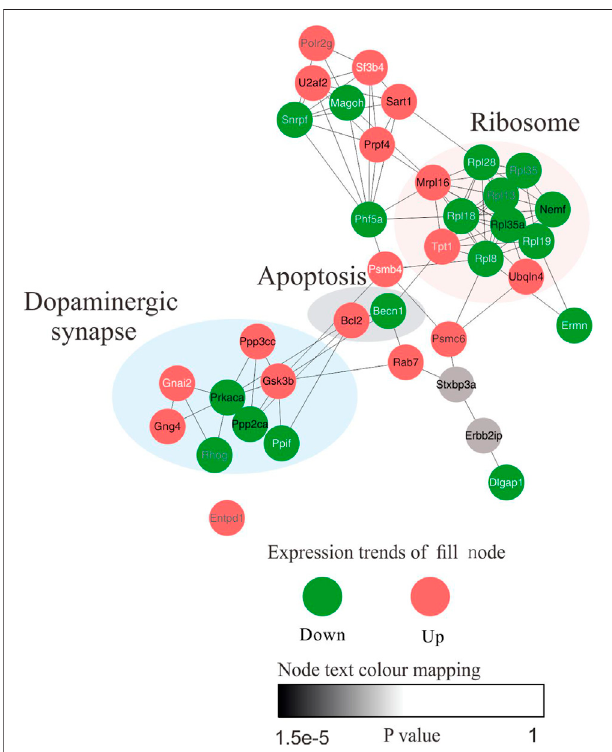
FIGURE 8 | The network model was constructed to elucidate the biological interpretations of hub proteins in the core network. Functional protein – protein interaction (PPI) network of the 135 proteins between control and model group was constructed. Top 35 nodes ranked by MCC. The node fi ll colour bar represent up-regulated (red) or down-regulated (green). The node text colour bar represents the p -value.